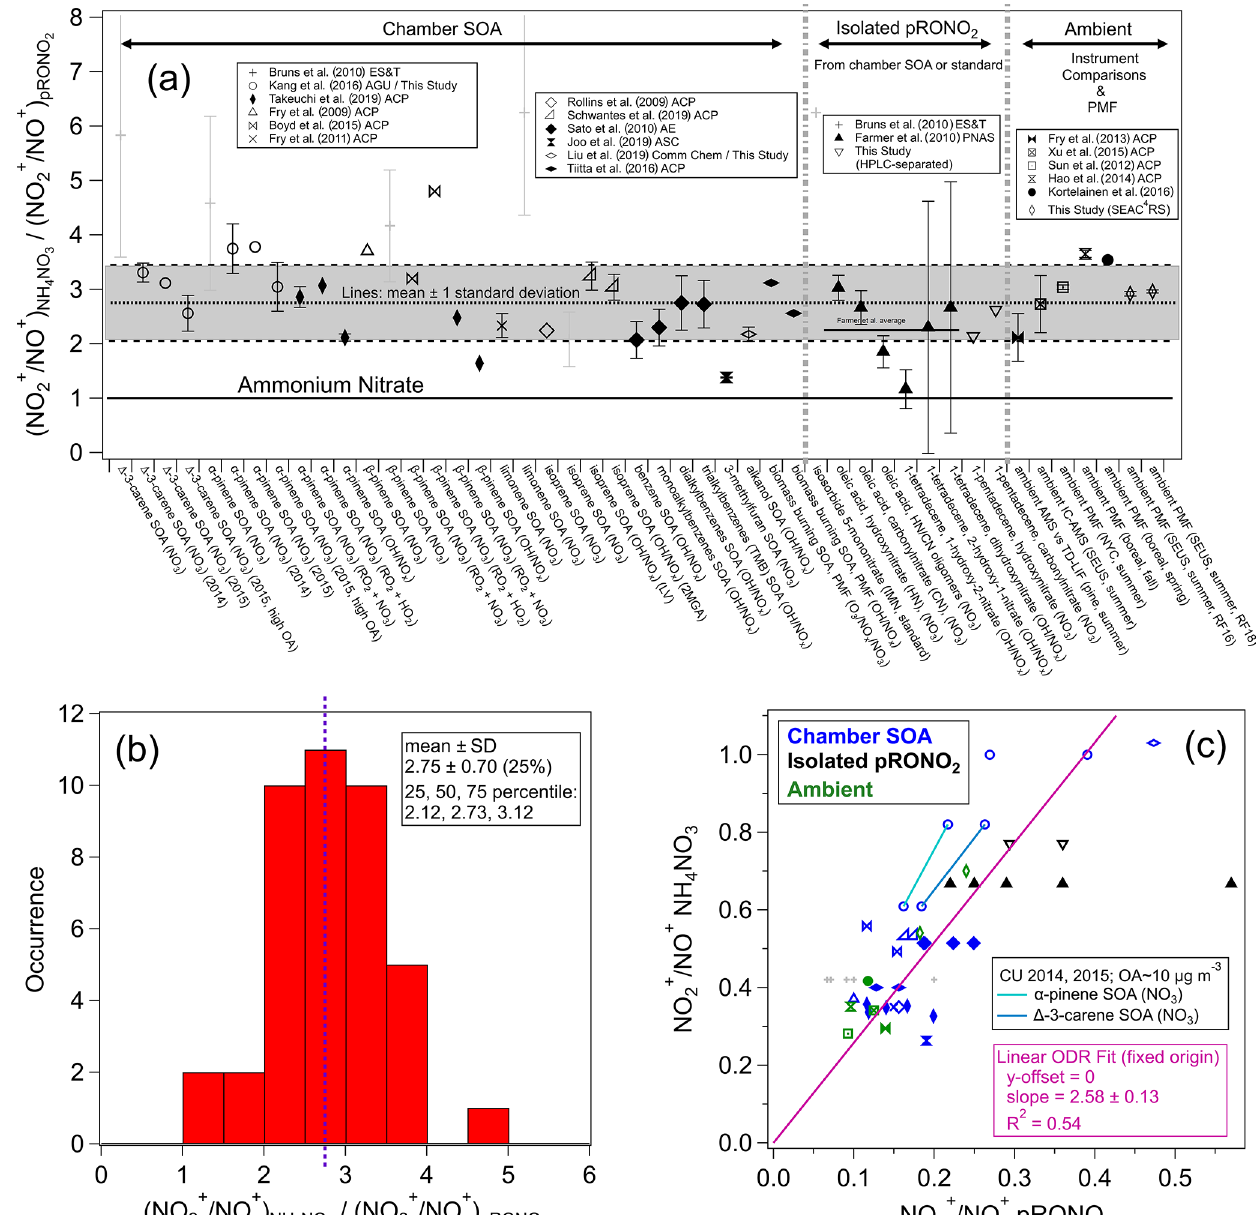
/ NO + ratios reported for chamber studies, pure organic nitrates, and Figure 1. (a) Survey of “Ratio-of-Ratios” (RoR) computed from NO + 2 field observations (using instrument comparisons or PMF separation). The mean (2.75) and standard deviation ( ± 0.70, ± 25%) are also shown (standard error for n = 41: ± 0.11, ± 4.0%). The light grey shading (“ + ” markers) indicates data that were not used in the average here, nor in the fits below (see Table S1 for rationale). Details of the values used to compute the ratios and uncertainties, data source, and any additional calculations for the information included in Fig. 1 are provided in Table S1. (b) Histogram and statistics of RoR. (c) Scatterplot of R NH vs. R pRONO . Linear least-squares lines are shown with orthogonal distance regression (ODR) fit (with intercept constrained 4 NO 3 2 through the origin, since offsets from unconstrained fits were not significant and for consistency with the apportionment equation). The data connected by cyan and green lines are averages from experiments conducted in our lab with two different AMSs (with substantially different calibration R NH ) while sampling the same type of SOA particles produced using the same two precursors mixtures. See Fig. S3 for the 4 NO 3 equivalent scatterplot, instead using NO + / NO + ratios and swapping the axes ( R pRONO vs. R NH 2 4 NO 3 2